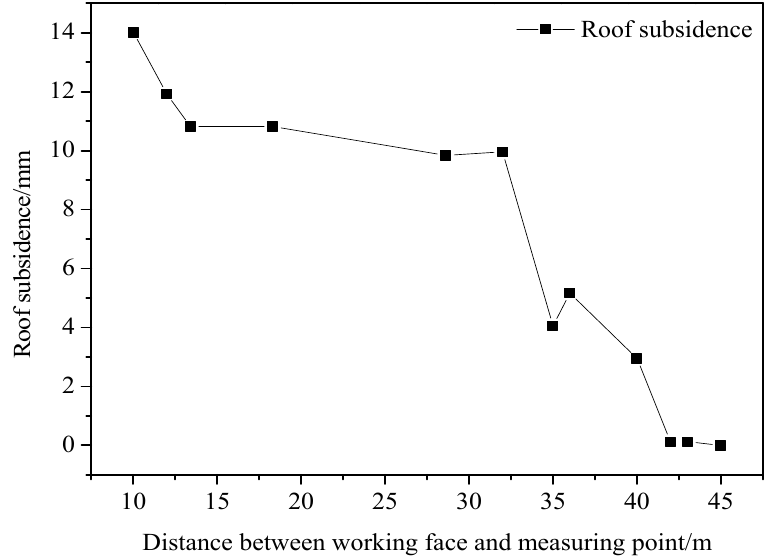
Figure 23. Variation curve of the roof subsidence for the roadway section.